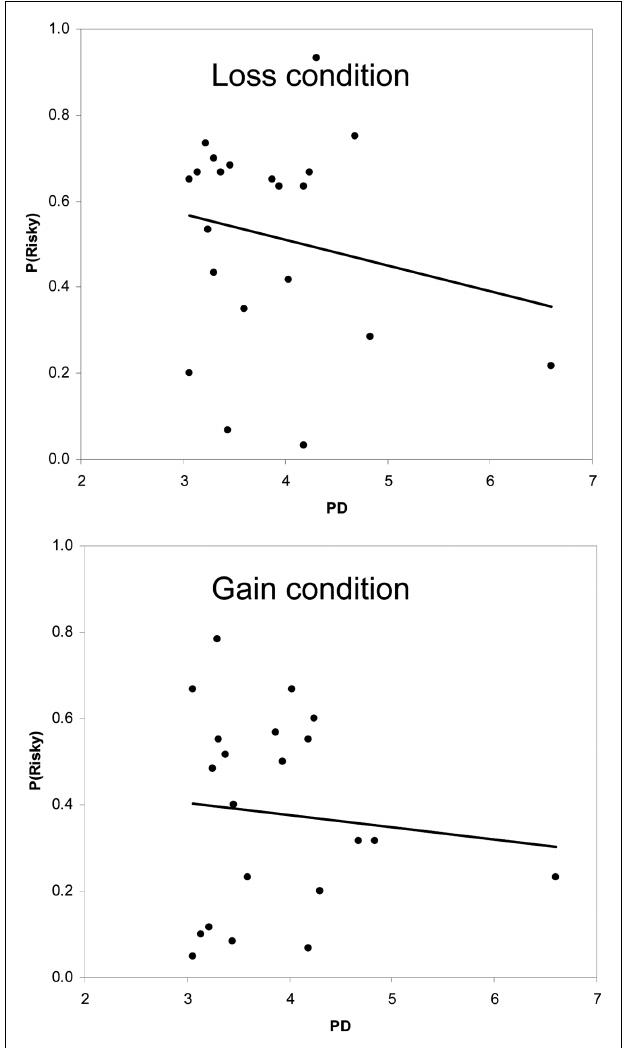
FIGURE 2 | Scatter plot and regression lines of the proportion of risky selections across 100 trials by pre-task PD in Study 1. Top: Loss condition. Bottom: Gain